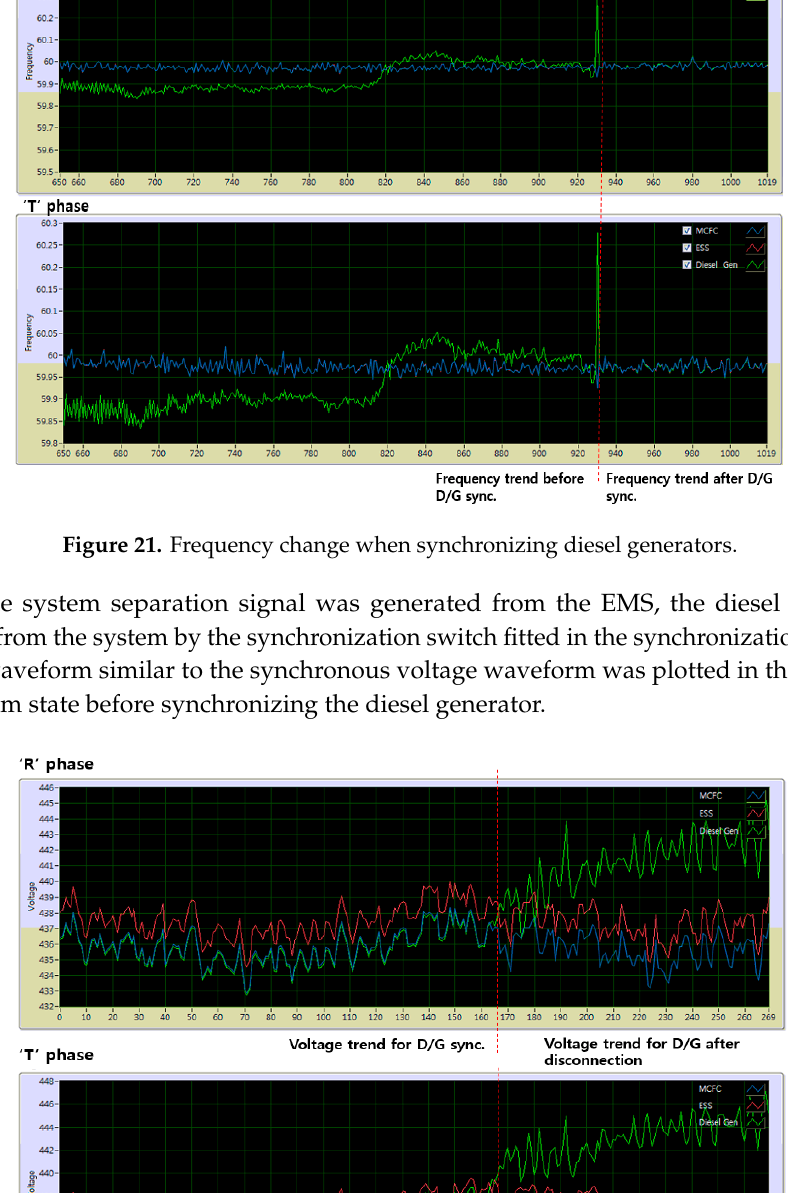
Figure 23. Frequency change when leaving diesel generator system. 7.3. Analysis of frequency variation rate and frequency stabilization time data based on load scenarios 7.3.1 Power data before and after synchronization for normal seagoing case 1